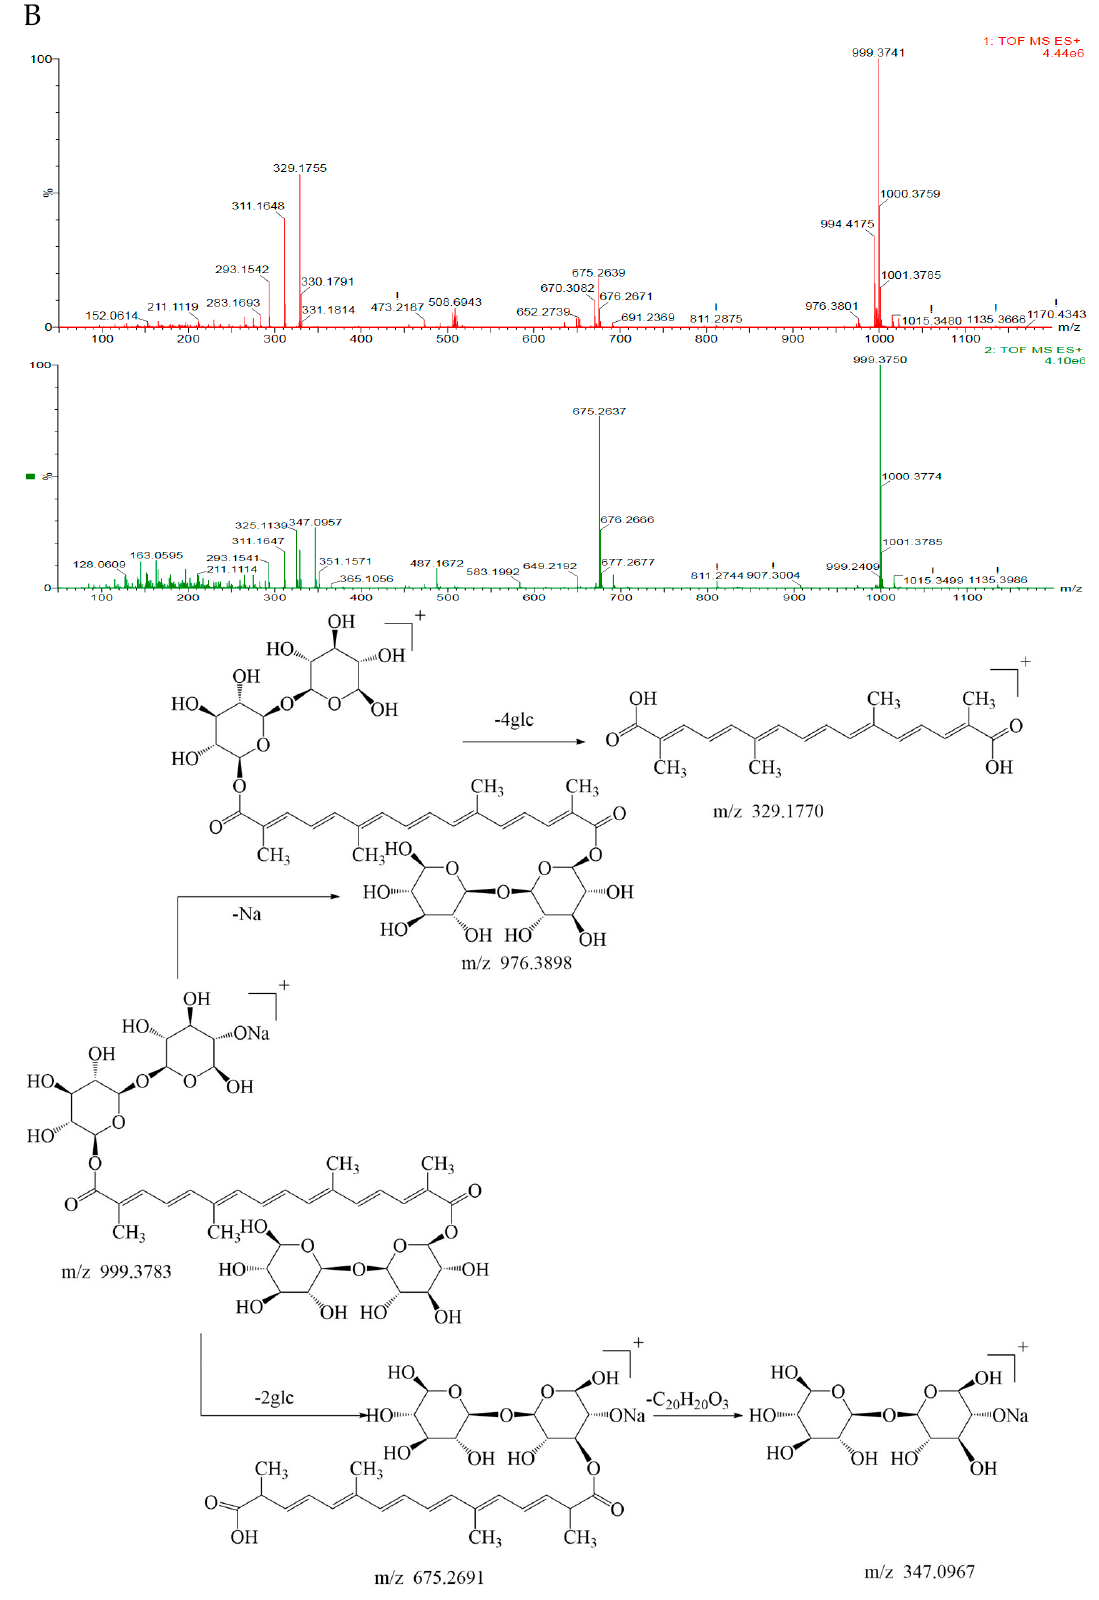
Figure 4. The TOF − MS, TOF − MS/MS spectra and the mass spectrometric fragmentation pathway of ( A ) geniposide and ( B ) crocin I. Table 1. Identification of the compounds in geniposide and crocetin using UPLC − ESI − QTOF − MS/MS in the positive ion mode.